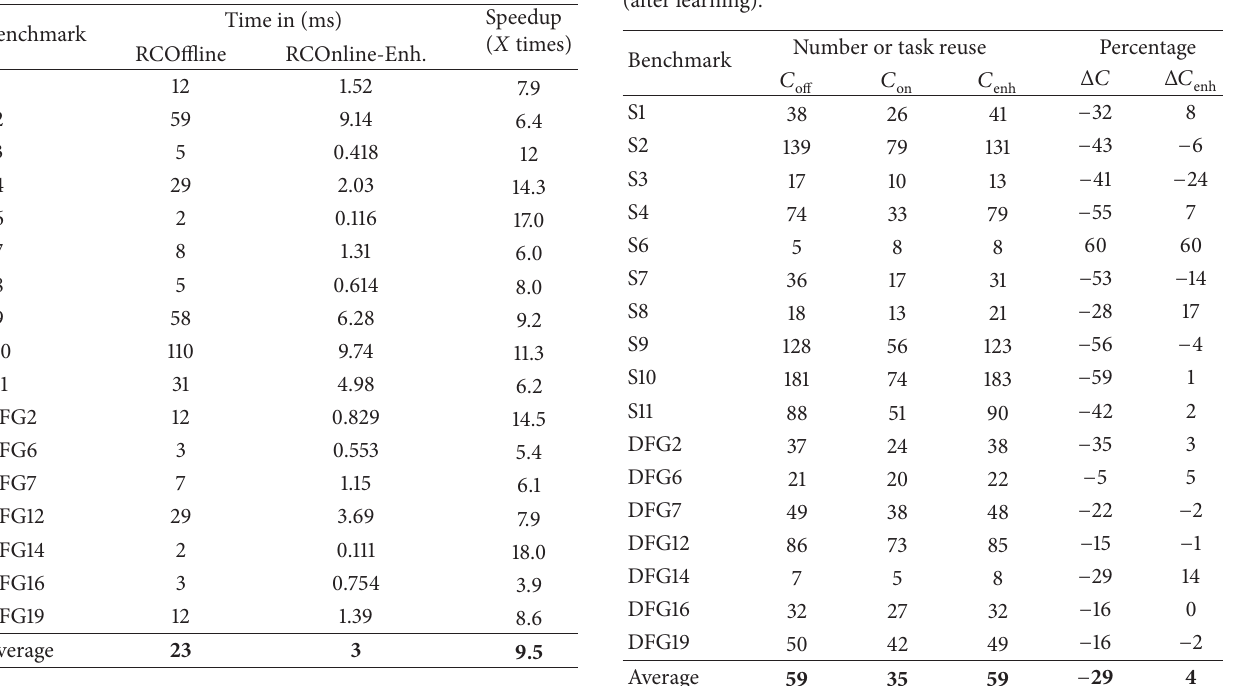
Table 4: Run-time comparison of RCOffline and RCOnline-Enh.